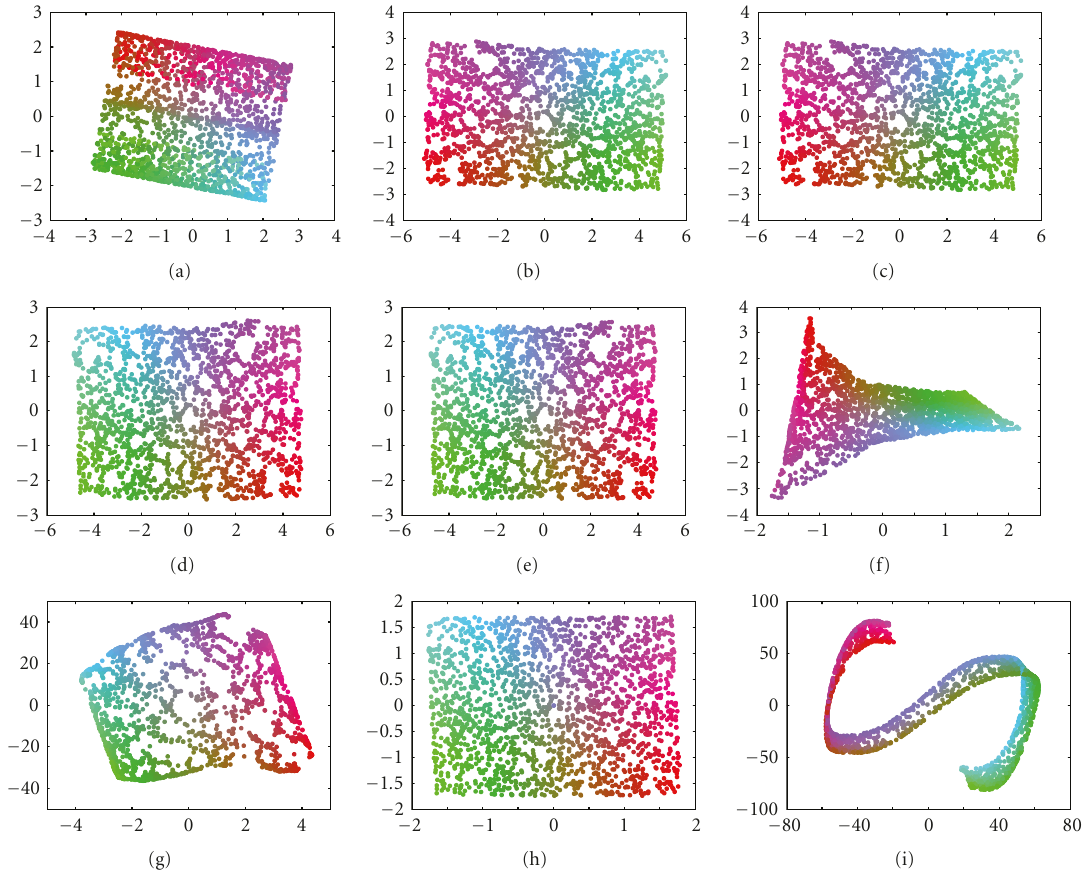
Figure 2: Reduced space computed by (a) PCA, (b) Isomap, (c) S P , (d) S SAM , (e) S CCA , (f) locally linear embedding, (g) Laplacian eigenmap, (h) Hessian eigenmap, and (i) di ff usion maps for the nonnoisy SCurve.